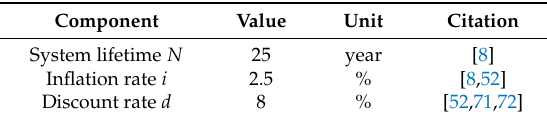
Table 14. Economic parameters used to calculate the PWF .